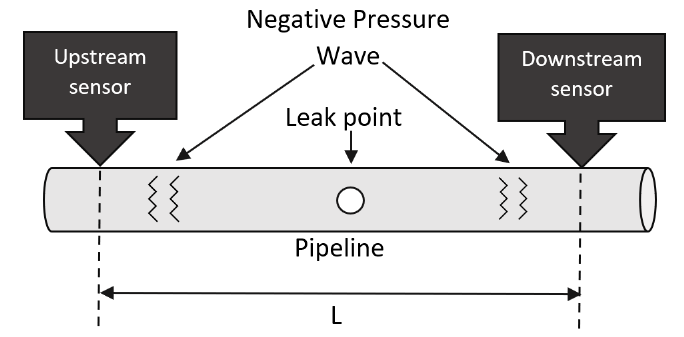
Figure 6. Negative Pressure Wave technique that applies from the leak site in the upstream and downstream directions